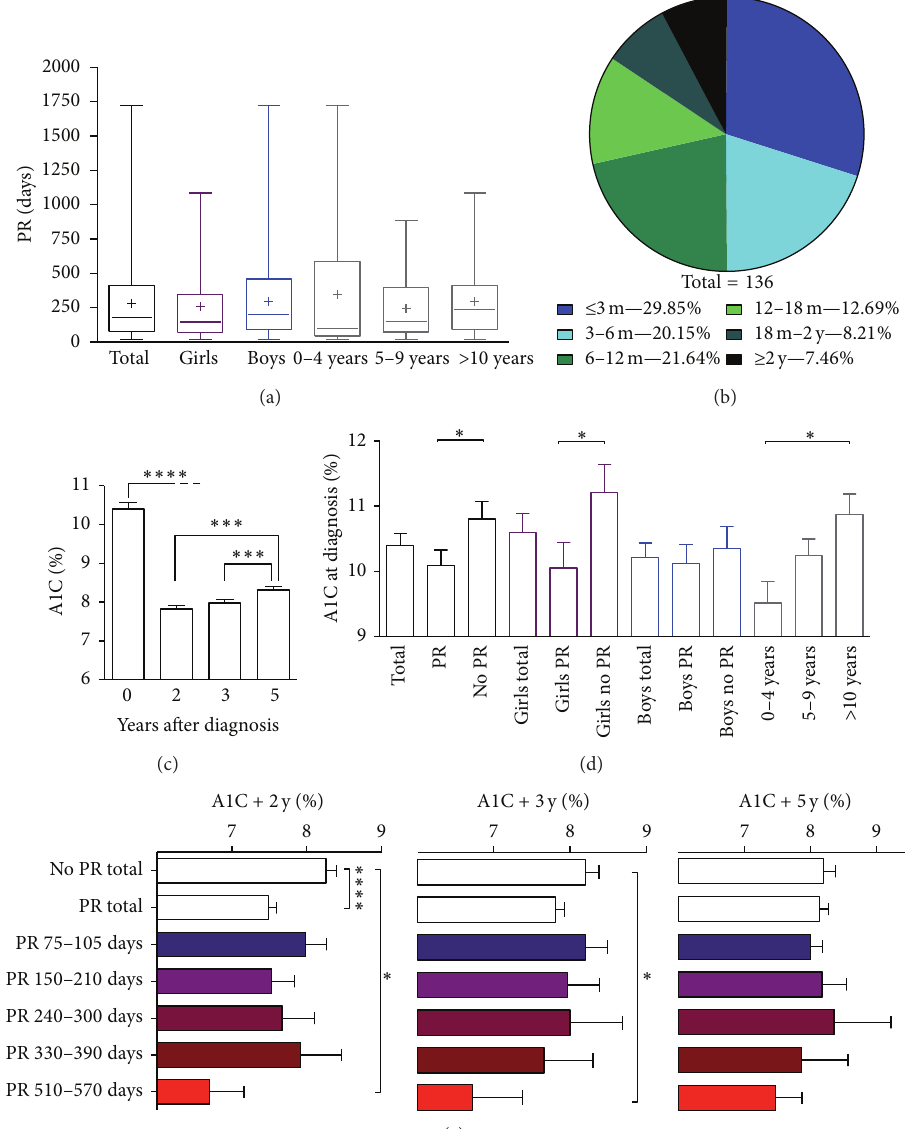
Figure 1: Characteristics of PR, A1C at diagnosis and during follow-up. (a) Box plots with ranges showing no difference in PR duration betweengenderandagesubgroups.[+]showsmeansforeachgroup.(b)DistributionofPRdurationsamongremitters( 𝑛 = 136 ).(c)Evolution of A1C levels during follow-up. (d) A1C levels at diagnosis among gender and age subgroups. (e) Graphs showing correlation between PR duration and A1C levels 2, 3, and 5 years after follow-up (resp., A1C+2y, A1C+3y, and A1C+5y). PR durations were grouped to correspond to 3 months ± 15 days and 6, 9, 12, and 18 months ± 30 days. All bars were shown with SEM. ∗ 𝑃 < 0.05 , ∗∗∗ 𝑃 < 0.001 , and ∗∗∗∗ 𝑃 < 0.0001 compared with indicated